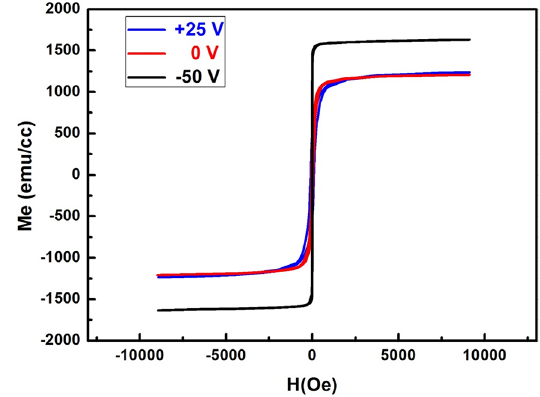
Figure 5. Hysteresis loop of the iron nitride films.